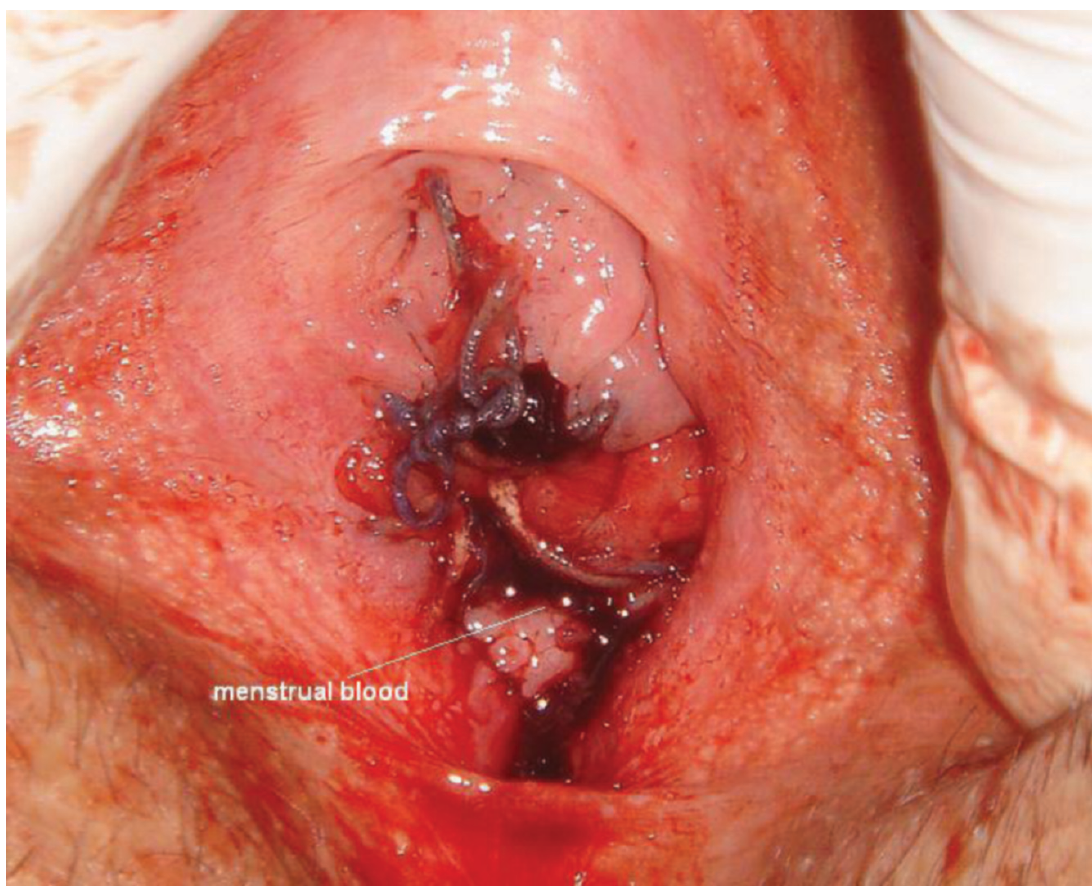
Figure 3. Sigmoidointroital anastomosis and the free flood of menstrual blood. of the intestinal segment to trauma [6-8]. Although sigmoid vaginoplasty has the potential risks of bowel complications, among four techniques developed to create a new neovagina, intestinal procedure has the best immediate and long term results